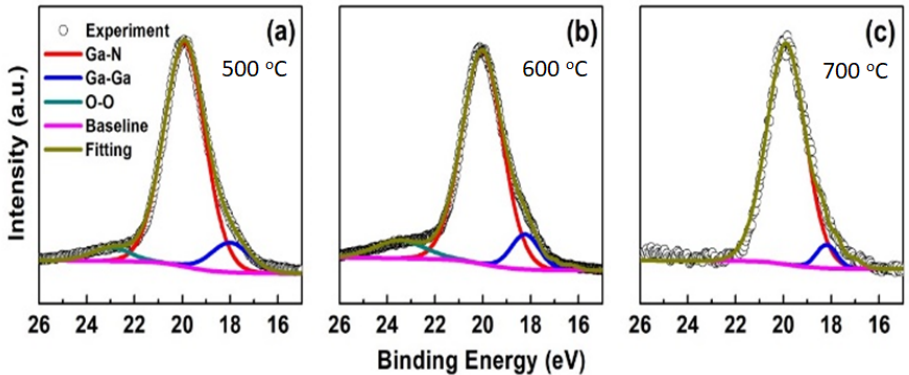
Figure 4. Ga-3d core-level spectra for GaN films: ( a ) T1: 500 °C, ( b ) T2: 600 °C, and ( c ) T3: 700 °C.